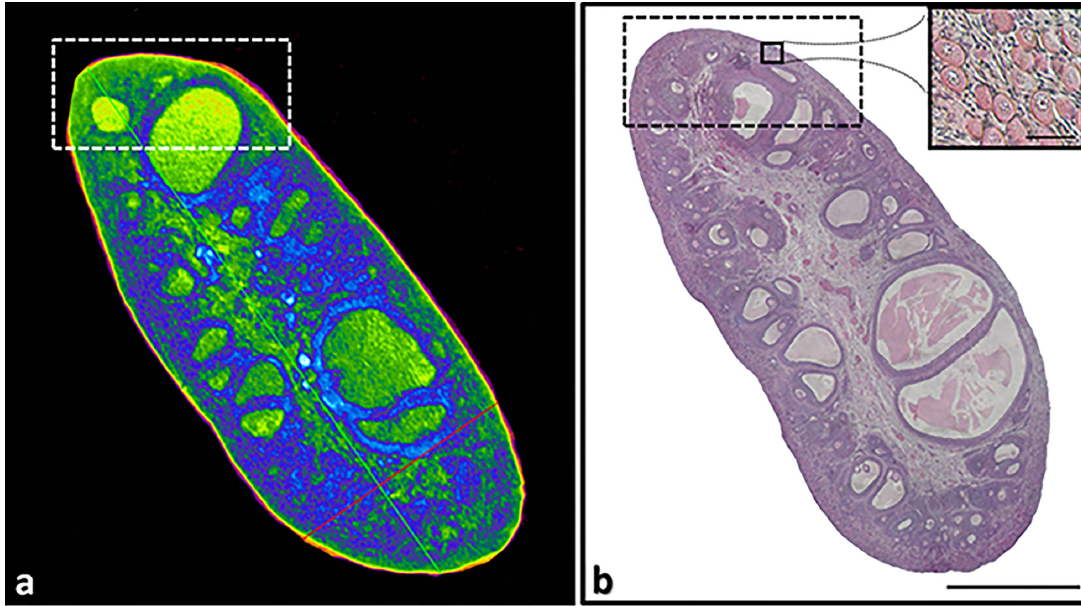
Figure 6 - MicroCT image using the color tool of the software DataViewer ( a ) and reconstructed histological section ( b ) of queen ovary (Barr = 2 mm). The region with preantral follicle is highlighted in green in the microCT image (dotted box), as well as the medullar area and the antrum of antral follicles. Insert : Amplified region with many preantral follicles (Barr = 50